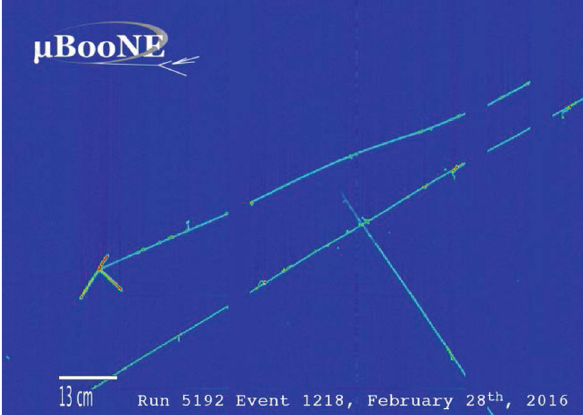
Fig. 1 Event display showing raw data for a region of the collec- tion plane associated with a candidate high-multiplicity neutrino event. Wire-number is represented on the horizontal axis, and time on the ver- tical. Color is associated with the charge deposition on each wire. Two perpendicularlycrossingtracksarecosmictrackswhichisthedominant background. The gaps in tracks are due to non-responsive wires in the detector [22]